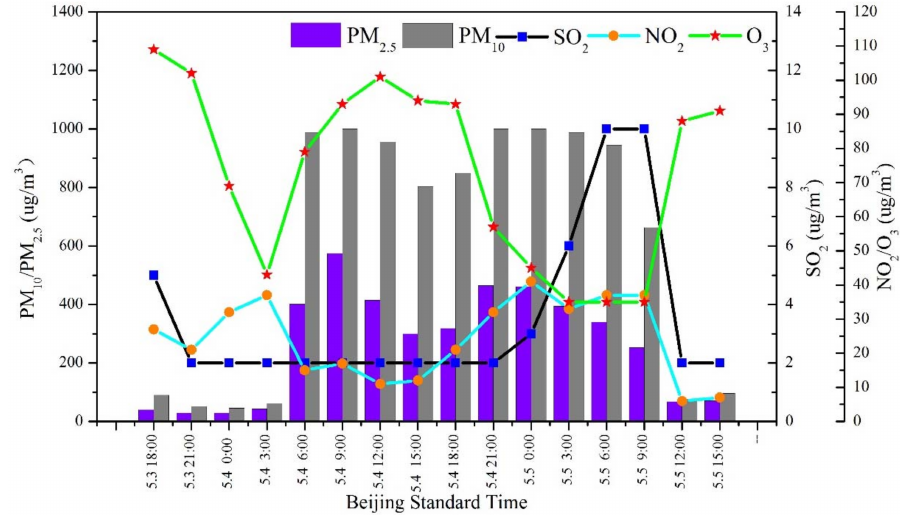
Figure 1. Changes in pollutant concentrations during the sampling